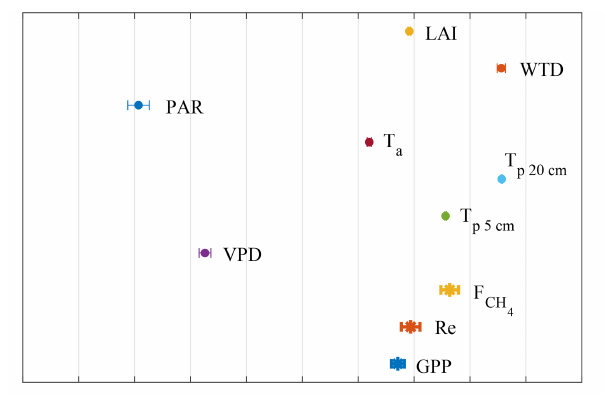
Figure 7. The 6-year average timing of the annual peaks in fluxes and their potential drivers. The bars give the 95% CI of the peak x